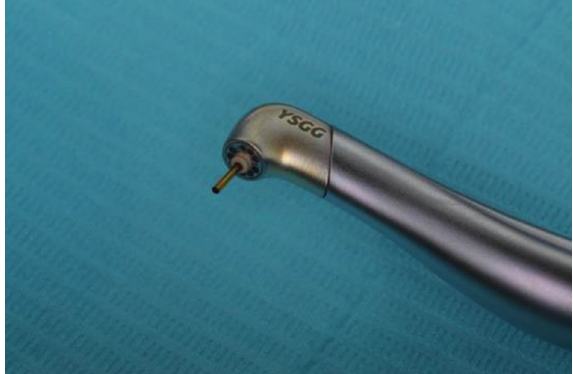
Figure 2: Gold handpiece with MZ10